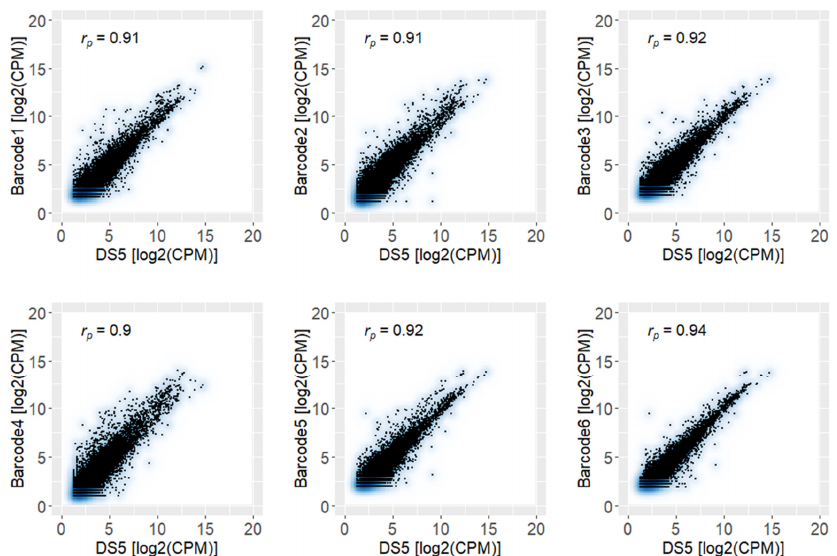
Figure 6. Correlation analysis of results obtained from the six barcoded samples with the smallest subset DS5. subset